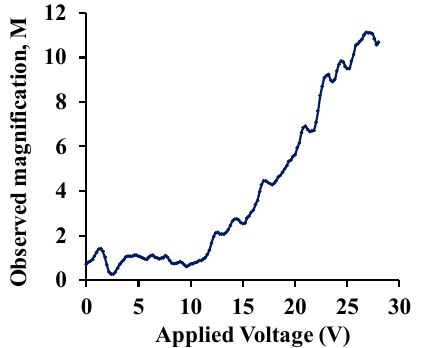
Figure 7. Observed sensor output magnification as a function of applied bias voltage at constant relative humidity.